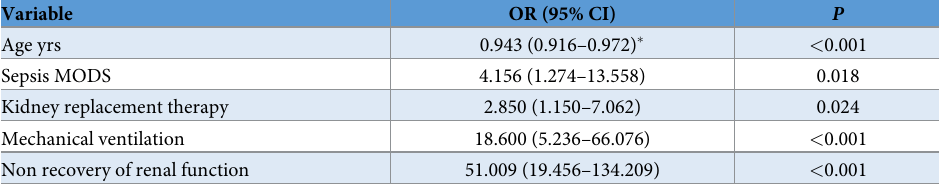
Table 4. Variables associated independently with mortality. Patients with proteinuria at admission. Variables entered in the model are listed in S4